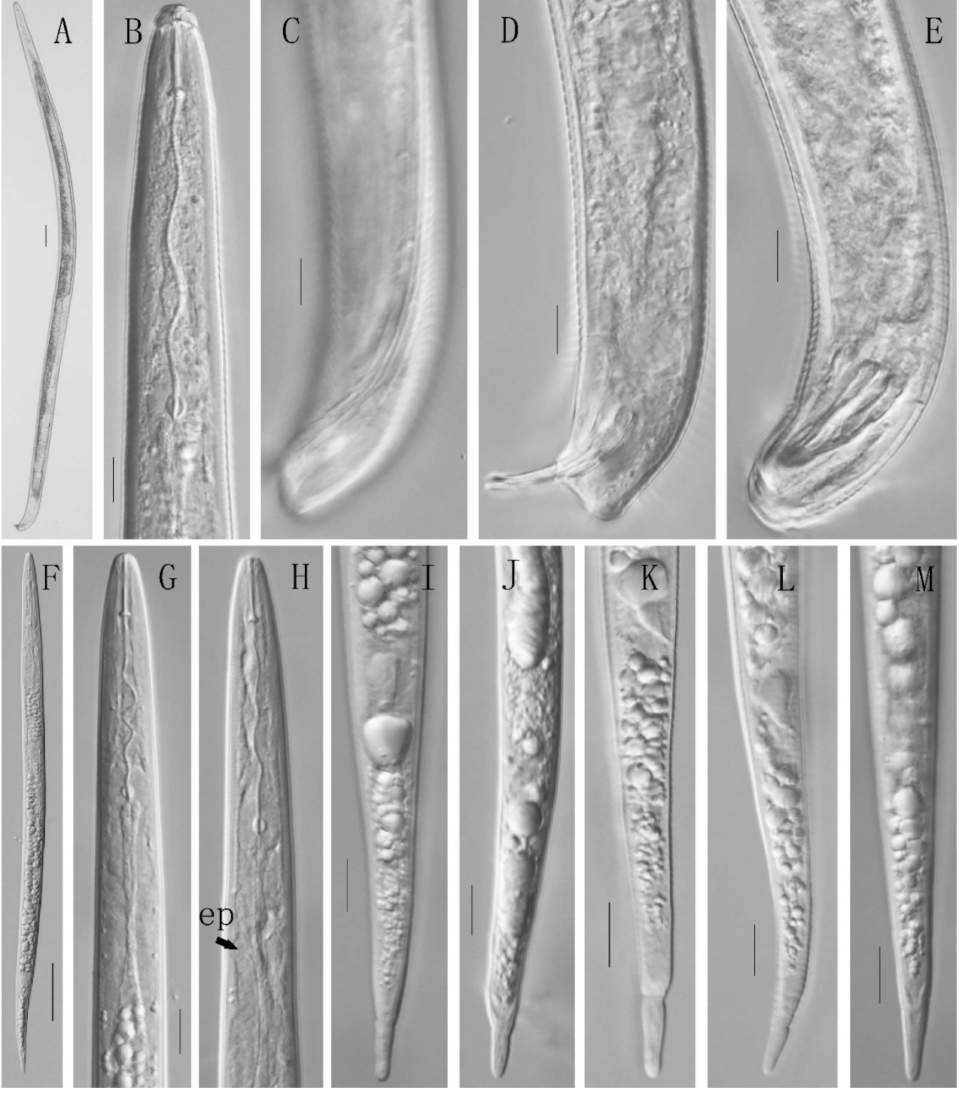
Figure 3. Adult male ( A – E ) and juvenile ( F – M ) of Meloidogyne graminis . ( A ): Entire male body; ( B ): Anterior male body; ( C ): Lateral field; ( D , E ): Male tails; ( F ): Entire juvenile body; ( G ): An- terior juvenile body; ( H ): Excretory pore (ep arrow); ( I – M ): Tails (Scale bars: ( A , F ) = 50 µ m; ( B – E , G – M ) = 10 µ